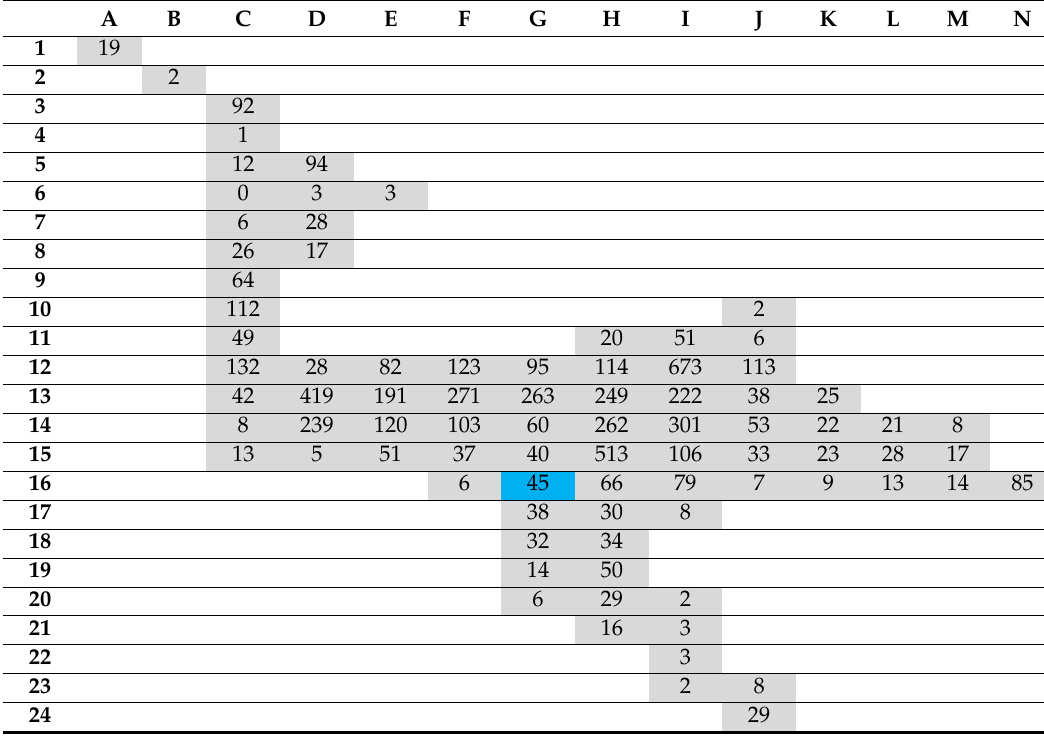
Table 4. Total water demand (m 3 / d) in particular subareas. The designations are in line with the ones used in Figure 2. The blue color corresponds to the water station A B